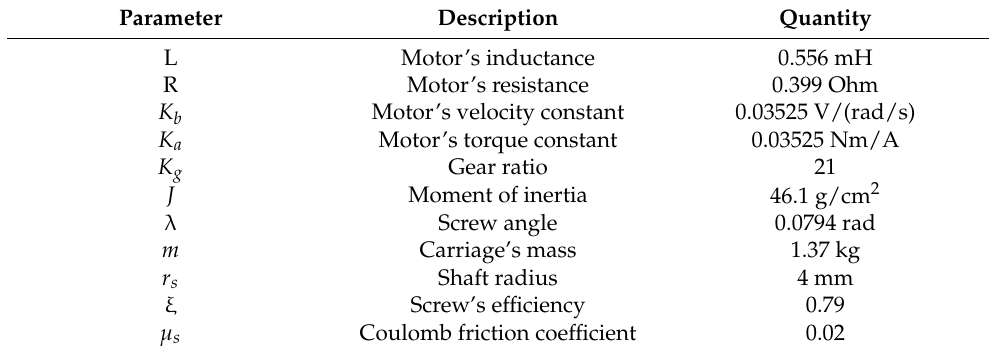
Table 2. Parameters in the linear